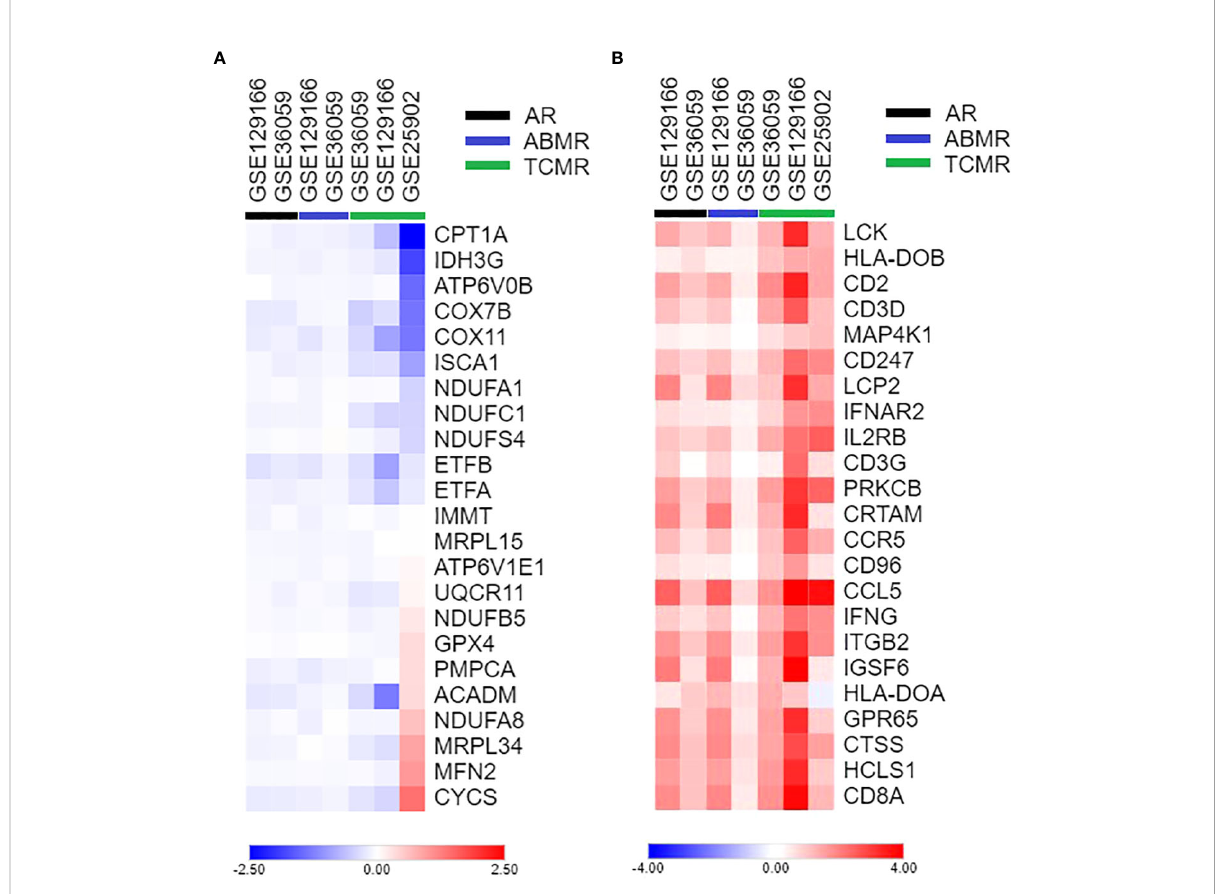
FIGURE 4 Heatmap of differentially expressed genes between acute rejection and stable graft groups. (A) Top 10 genes of allograft rejection GSEA gene set and in fl ammasomes. (B) Top 10 genes of oxidative phosphorylation GSEA gene set and in fl ammasomes. GSEA, Gene Set Enrichment Analysis.